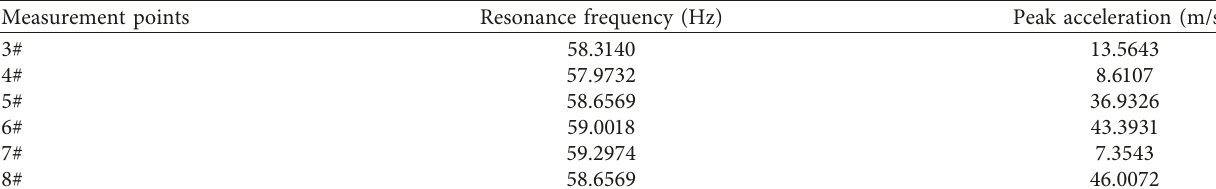
Table 10: 2# test piece resonance point information.